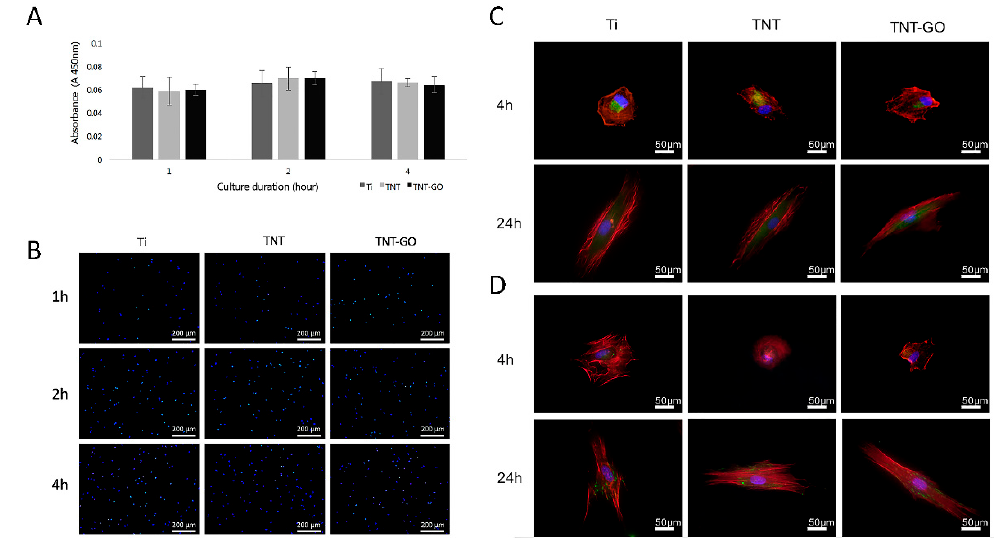
Figure 7. Cell analysis at 1, 2, and 4 h after inhibiting the Erk1/2 signaling pathway. ( A ) Cell adhesion of HGFs; ( B ) DAPI staining of adherent HGFs; immunofluorescence staining of ( C ) vinculin and ( D ) integrin β 1.